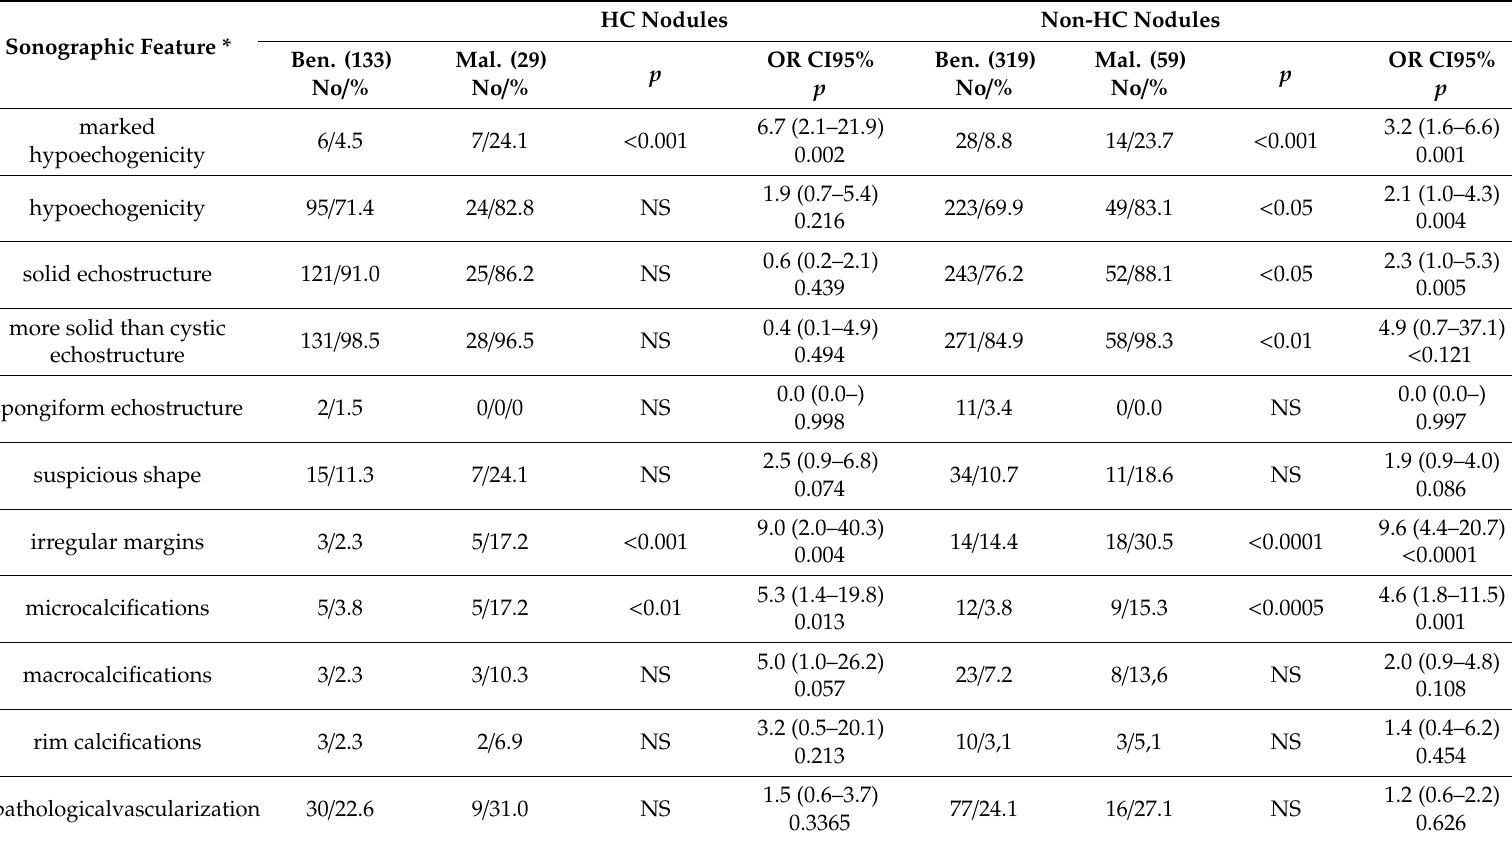
Table 2. Comparison of the incidence of sonographic features in HC and non-HC nodules in relation to the histopathological outcome: benign lesion vs. thyroid malignancy. Results of univariate logistic regression analysis in both